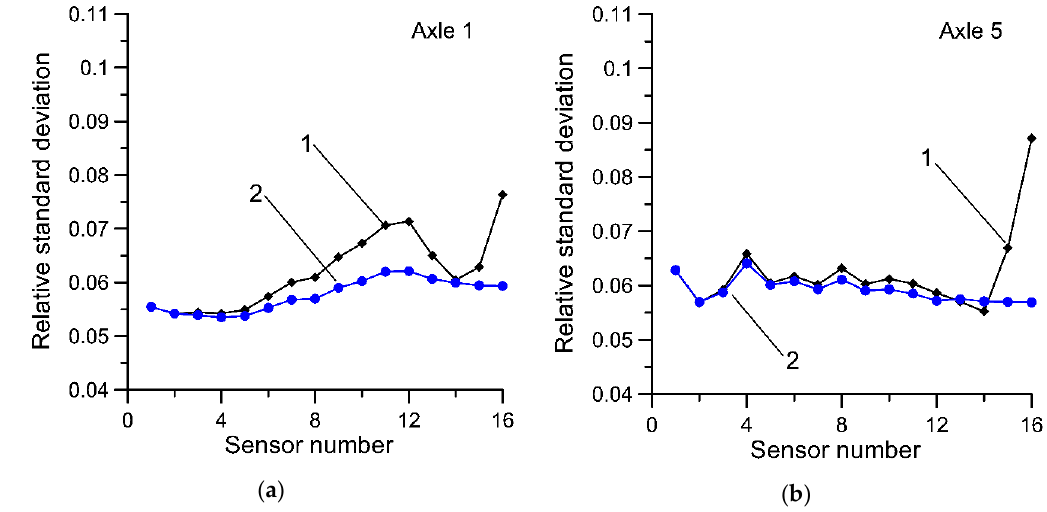
Figure 7. Relative standard deviation of estimates of static axle load, ( a )—axle no. 1; ( b )—axle no. 5; with results averaged in order of increasing uncertainty of the results. Curve 1—results for Equation (1), curve 2—results for Equation (7).